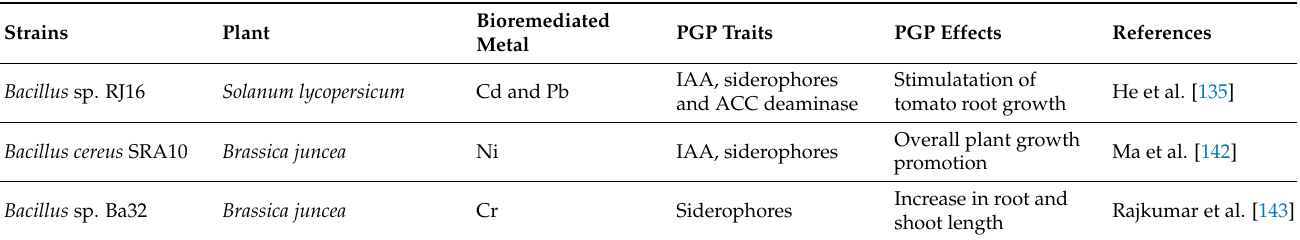
Table 1. Phytoremediation supporting bacteria of the genus Bacillus , and their